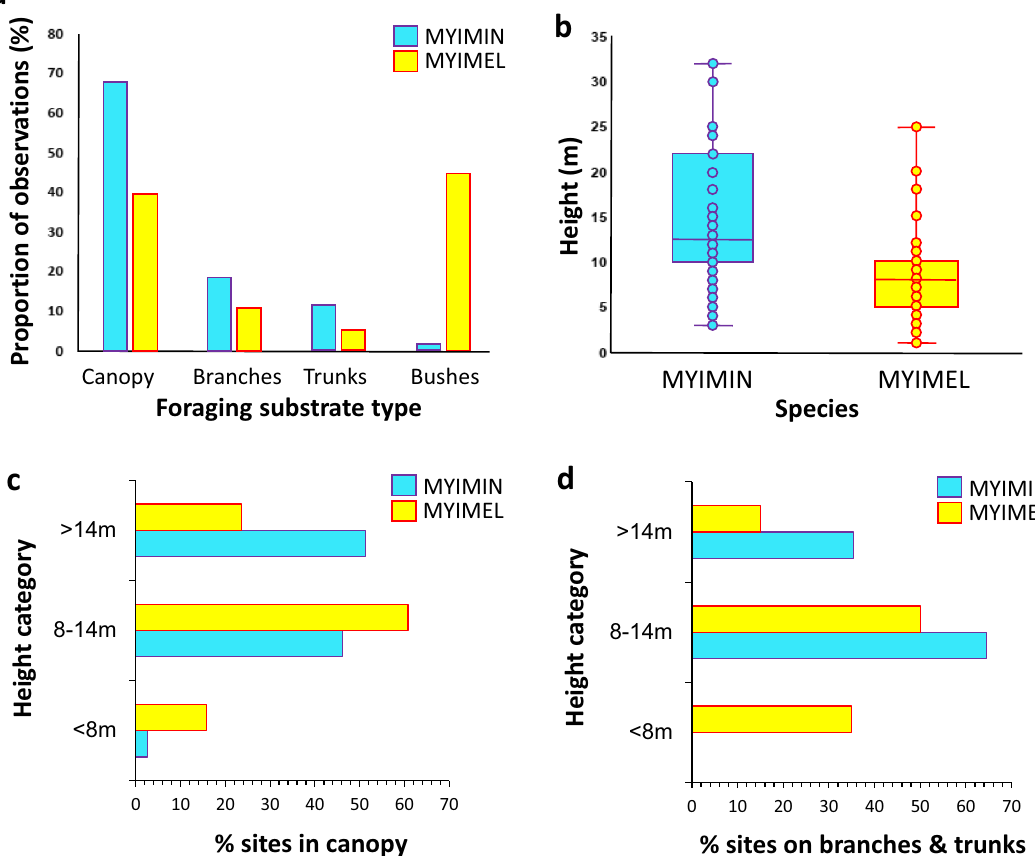
Figure 4. Comparison between M. miniatus (MYIMIN) and M. melanocephalus (MYIMEL) in their use of foraging sites. ( a ) Distribution of foraging sites ( n = 168 and n = 129 for M. miniatus and M. melanocephalus, respectively) among the four substrate types; ( b ) Foraging height of n = 168 and n = 129 foraging sites records of M. miniatus and M. melanocephalus respectively; ( c ) Distribution of foraging sites in canopies according to the height category for M. miniatus ( n = 117 records) and M. melanocephalus ( n = 51); ( d ) Distribution of foraging sites on branches and trunks according to the height category for M. miniatus ( n = 48 records) and M. melanocephalus ( n = 20). Parts ( c ) and ( d ) are based on values reported in Supplementary Table